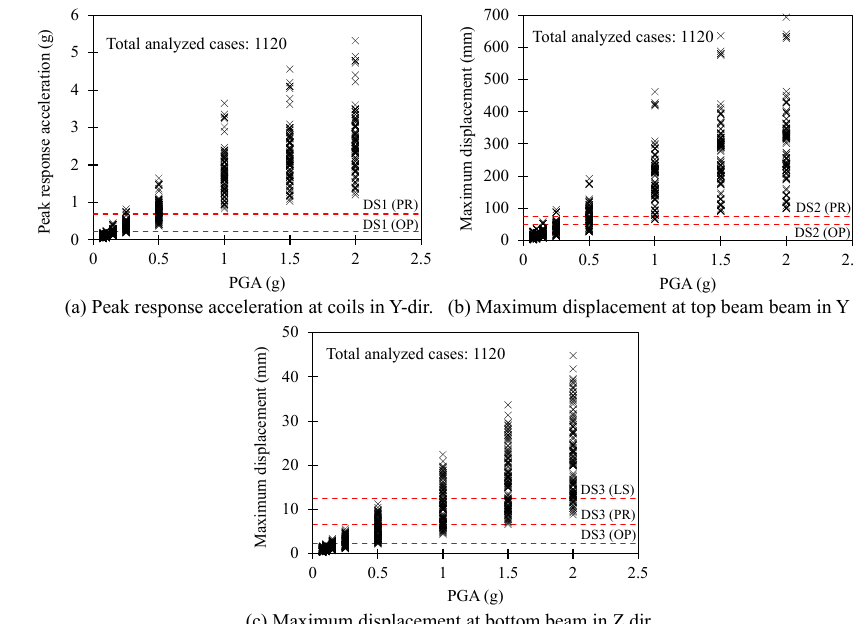
Figure 17. Variation of critical dynamic responses according to PGA obtained from analytical results.